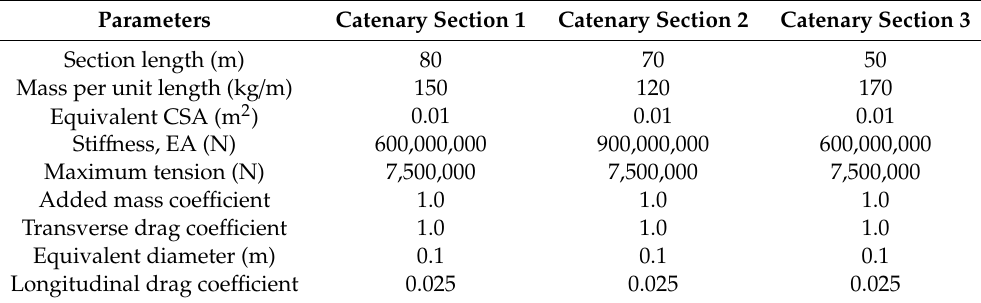
Table 3. Parameters of the catenary mooring lines. Table 3 . Parameters of the catenary mooring lines.